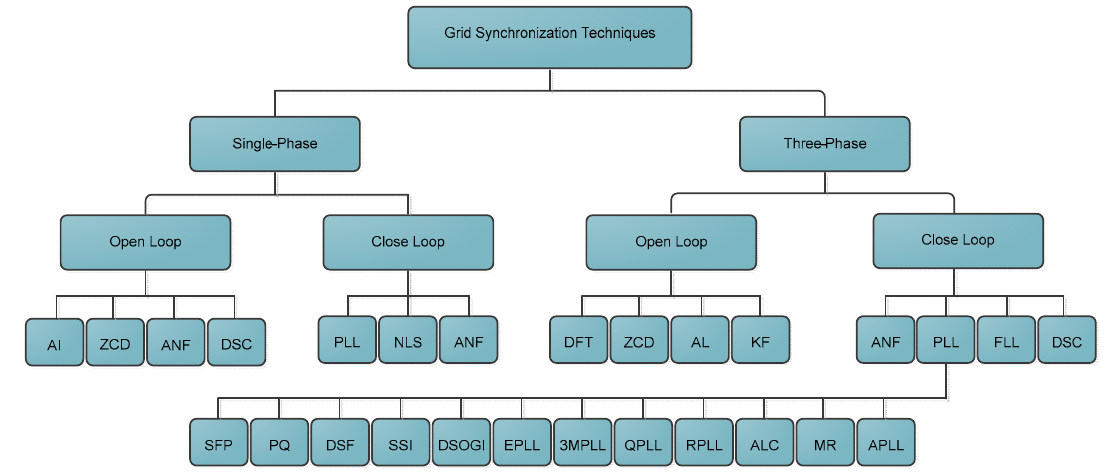
Figure 19. Classification of grid synchronization techniques.